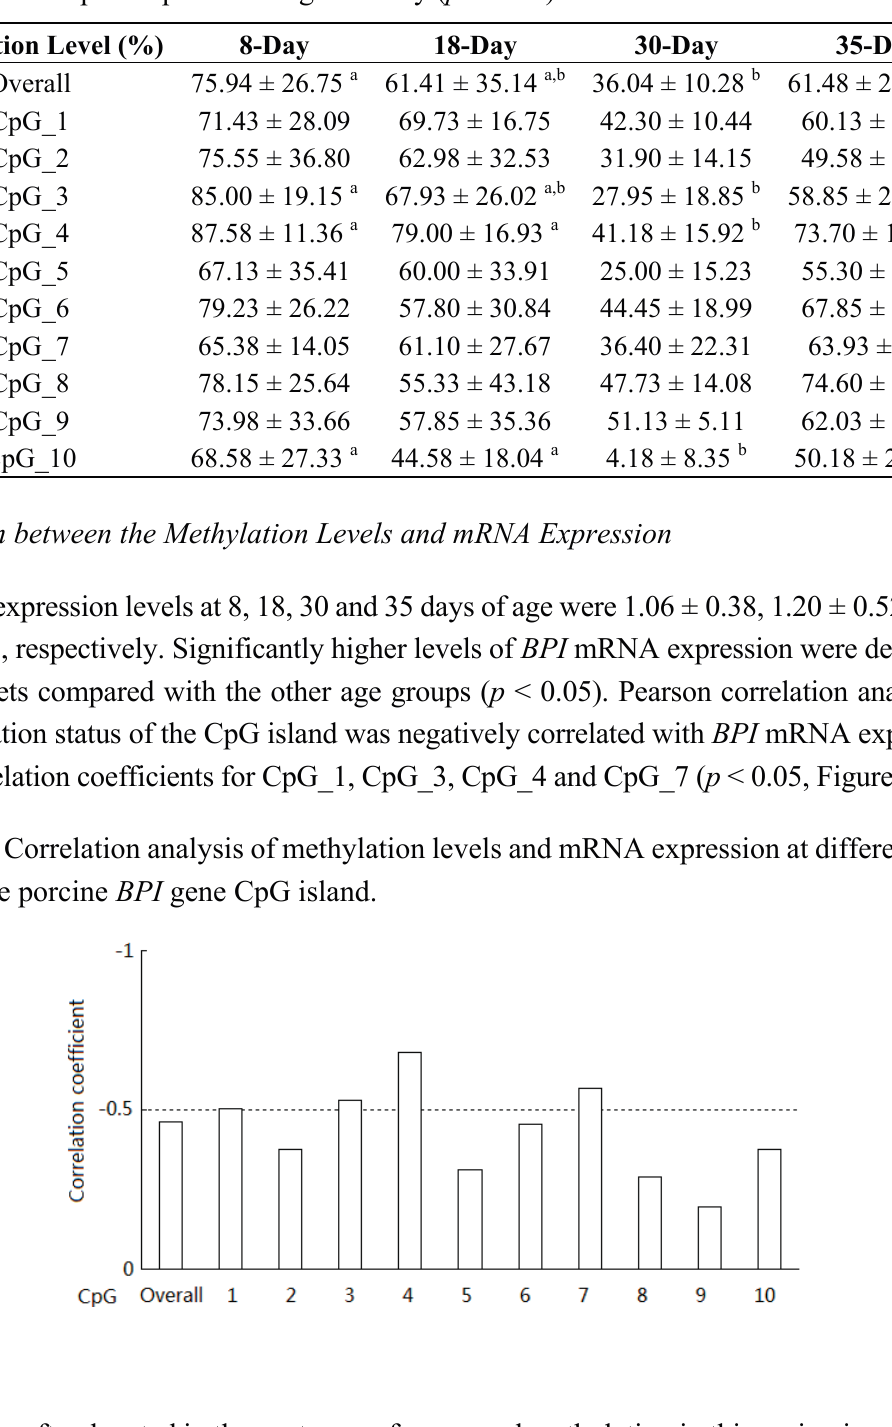
Table 2. Average methylation levels of overall and single CpG sites in the porcine BPI gene in the different age groups; Figure in the table is mean ± SE; a,b The means in the same row with different superscripts differ significantly ( p < 0.05).